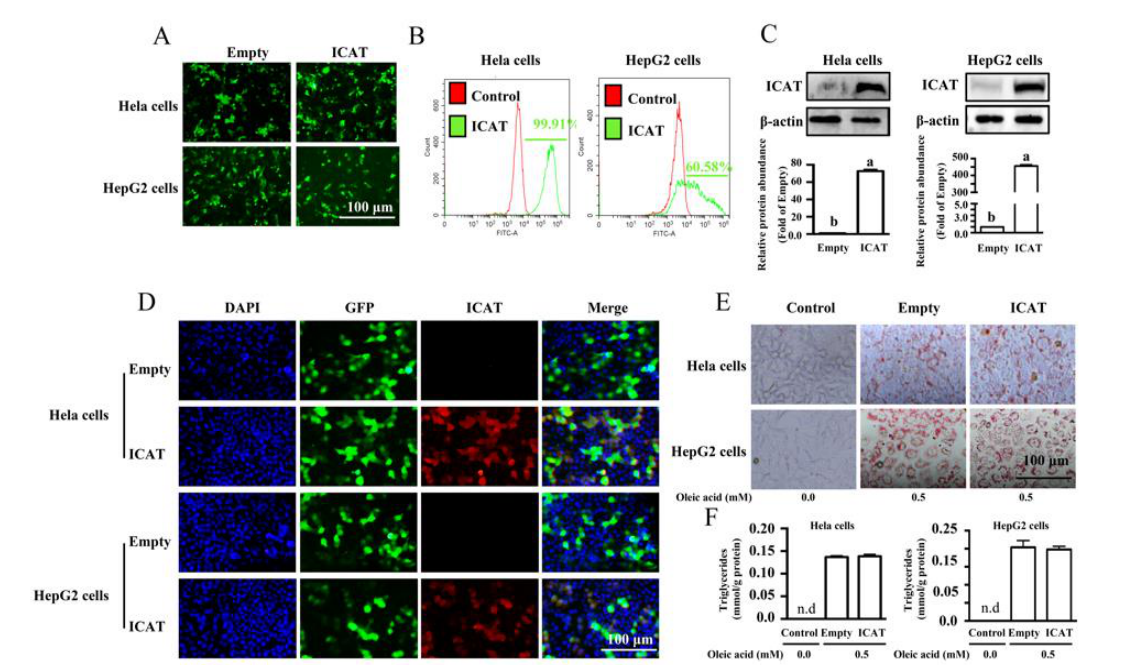
Figure 6. ICAT did not affect lipid accumulation in Hela and HepG2 cells. ( A ) The transfection efficiency and ( B ) purity of Hela and HepG2 cells stably expressed ICAT. ( C ) Protein levels and ( D ) in situ expressions of ICAT in both cell lines. ( E ) Representative micrographs of cells stained with oil red O. ( F ) TG contents of Hela and HepG2 after 0.5 mmol/L oleic acid treatment. Values are means ± SEMs, n = 3 independent experiments. Means without a common letter differ, p < 0.05. ICAT, Inhibitor of β-catenin and TCF4.